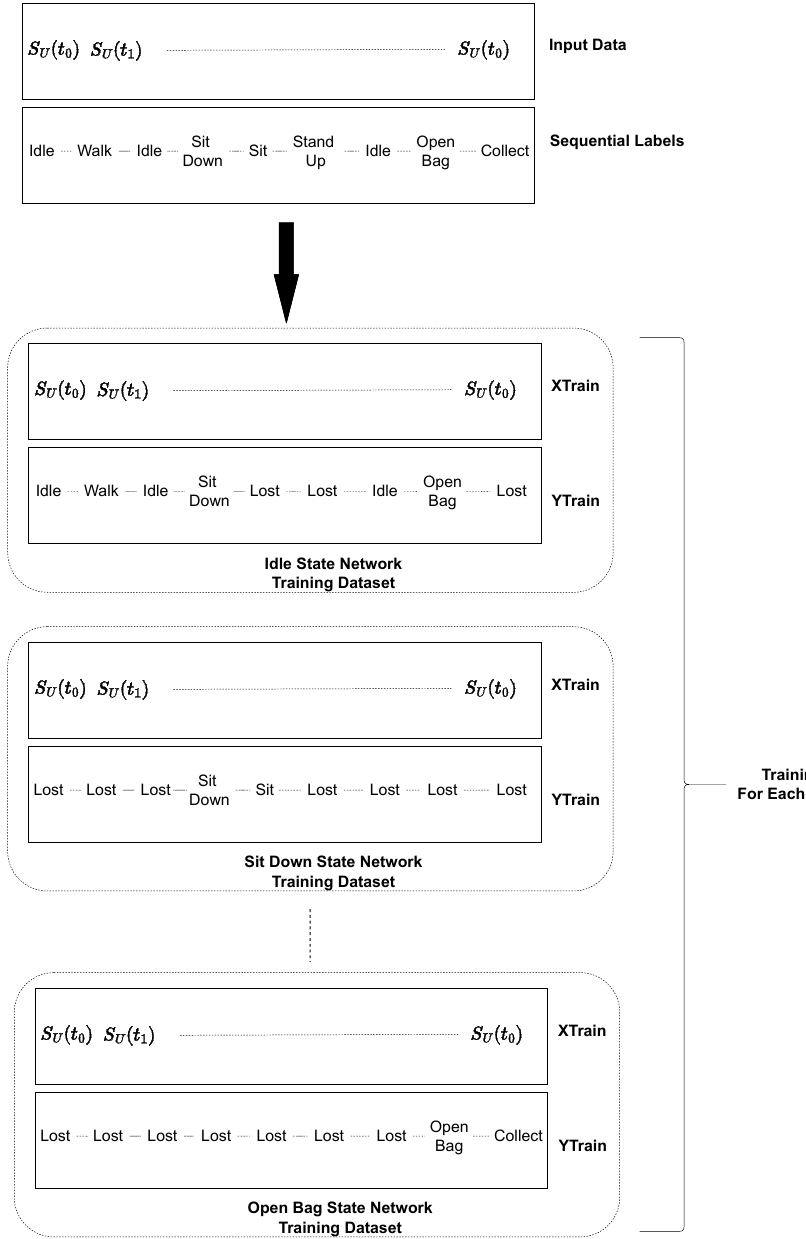
Figure 8. LSTM training